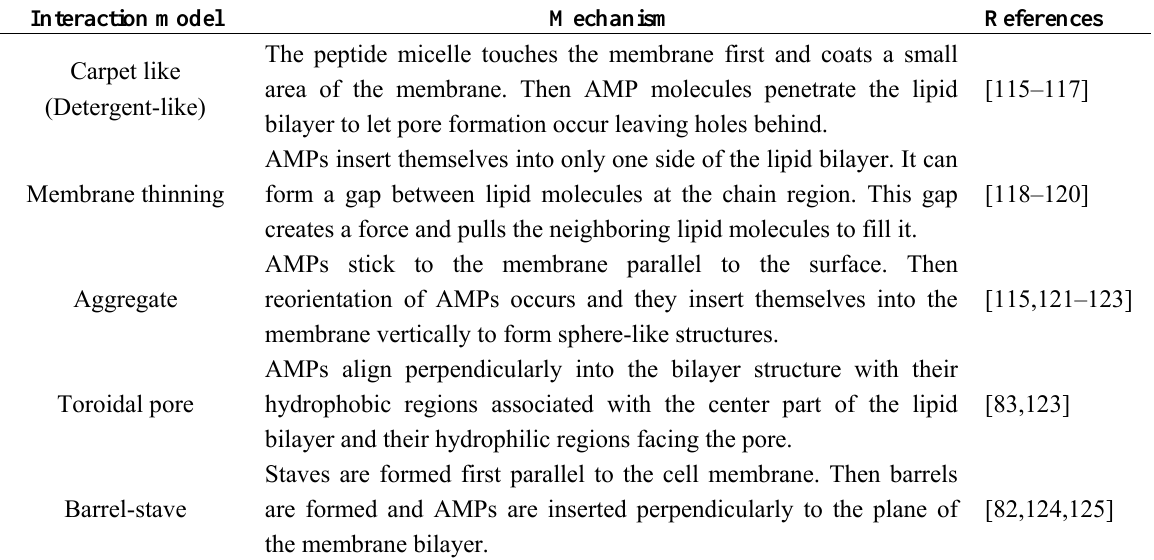
Table 1. The action mechanisms of membrane-active AMPs.